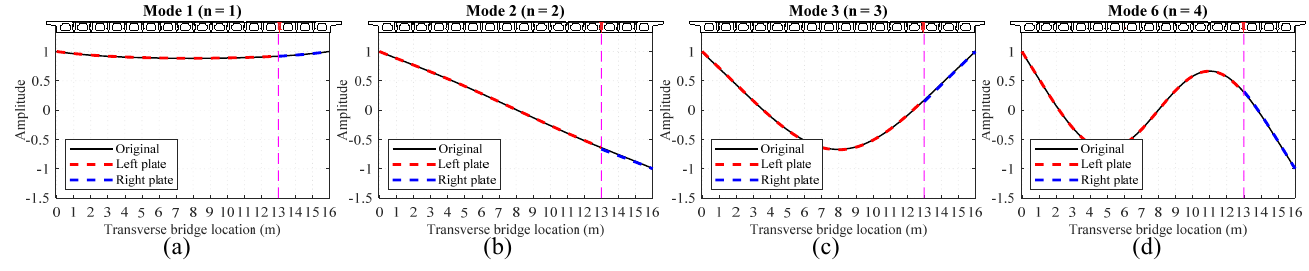
Figure 11. Comparison of the first four transverse modal shapes: hinge position η = 13 m: ( a ) Mode 1, n = 1; ( b ) Mode 2, n = 2; ( c ) Mode 3, n = 3; ( d ) Mode 6, n = 4.